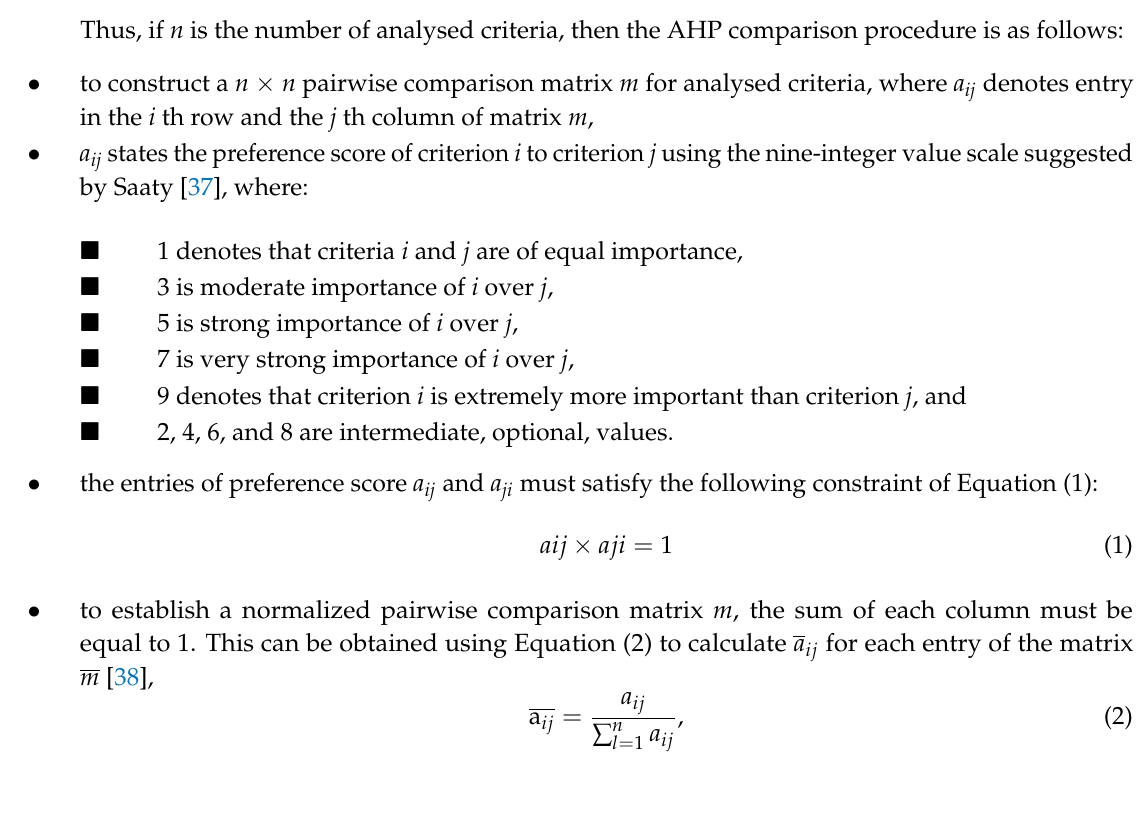
Figure 3. Decision hierarchy for waste site selection (3rd level repeats and is shown for one criterion only).